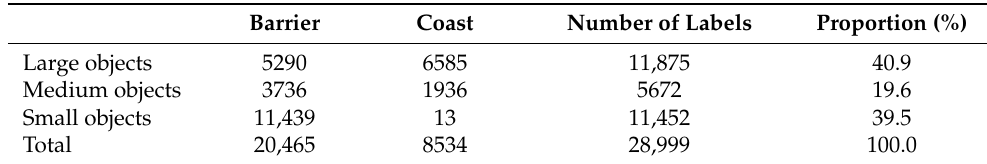
Table 1. Statistics of the number of large, medium, and small objects.